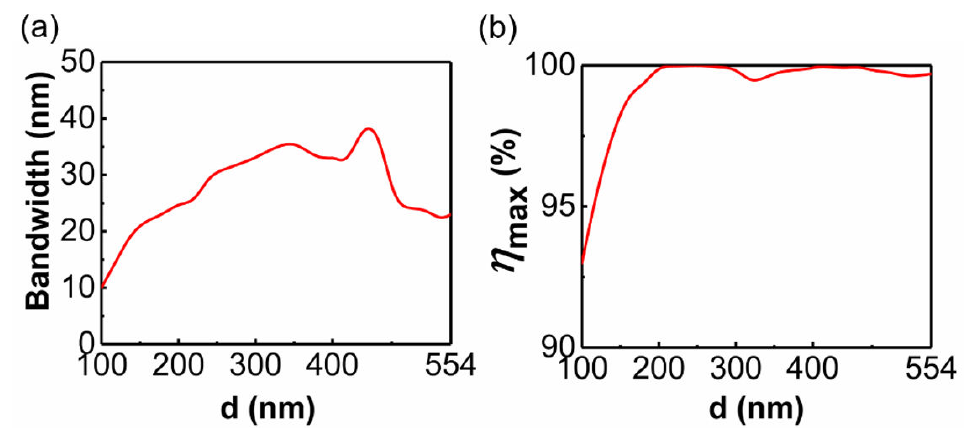
Figure 5. The simulated optical performances for the metasurface with different d under the y- polarized incidence. ( a ) The bandwidth of the metasurface operating as an efficient beam splitter. The band with a conversion efficiency higher than 90% is regarded as the operating band. ( b ) The highest conversion efficiency η max in the corresponding wave band.